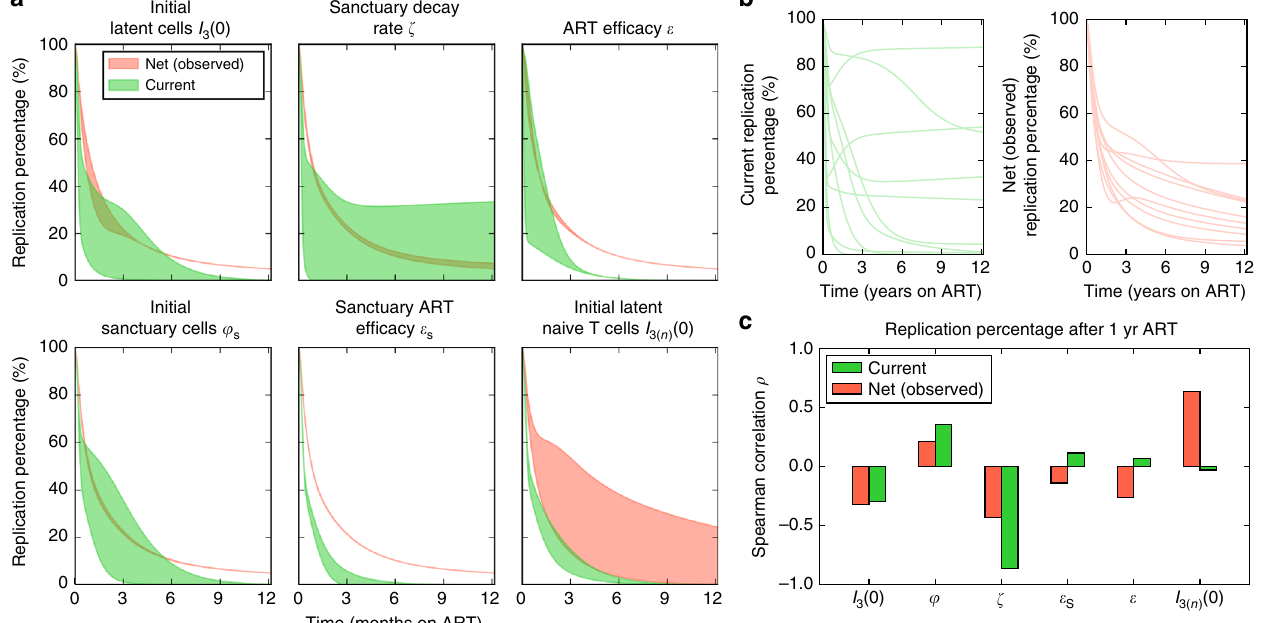
Fig. 9 Sensitivity analysis of model results. a – c See Methods for complete simulated parameter ranges. a Local sensitivity analysis (green: current; red: net, or observed) revealed no meaningful difference in percentage of new infected cells generated by viral replication after a year of ART despite variability in initial reservoir volume I 3 (0), sanctuary fraction φ S , and ART effectiveness in and out of the sanctuary ( ϵ and ϵ ). Only an extremely low, or zero, sanctuary S decay rate ζ predicted that a meaningful percentage (25%) of infected cells would be newly generated by HIV replication at one year, despite the fact that signals of evolution are not typically observed at this time point. Including a high percentage of slowly proliferating naive CD4 + T cells (T n ) in the reservoir alters the percentage of net, but not current, replication percentage. b 25 examples from 1000 global sensitivity analysis simulations. HIV replication accounted for fewer than 25% of current and net infected cells after a year of ART in a majority of simulations. c The parameters most correlated with current and net replication percentage at 1 year of ART are different. Current replication percentage inversely correlates with sanctuary decay rate while net (observed) replication percentage positively correlates with reservoir composition (quanti fi ed with the fraction of naive latently infected cells). Correlations are measured with the Spearman correlation coef fi